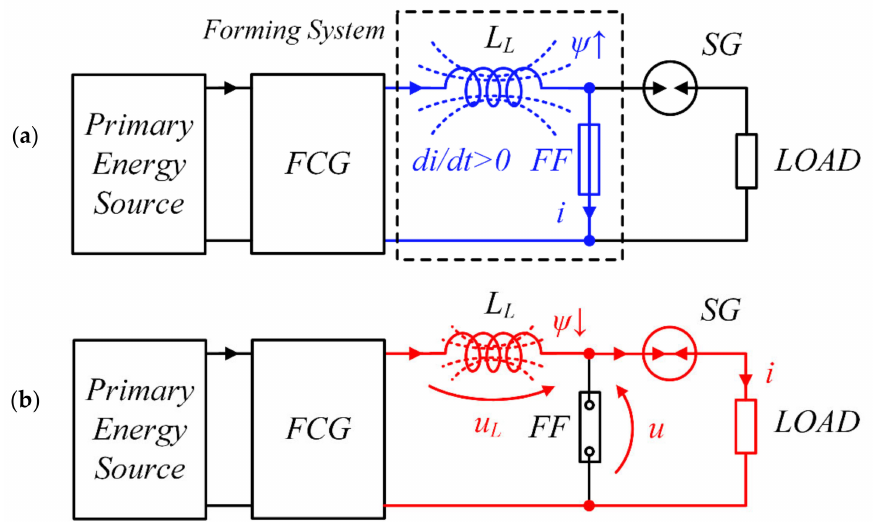
Figure 7. Simplified schematic diagram of the PFS during two stages of operation: current increase in the forming coil ( a ) and rapid current limitation by FF ( b ): i —forming coil current, u L —forming coil voltage, u —forming fuse voltage, Ψ —magnetic flux of a forming coil, SG —spark